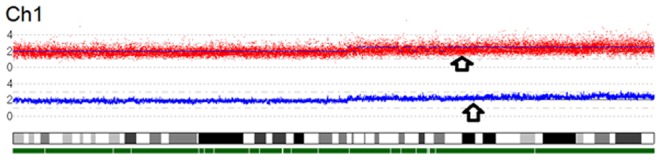
Example of CNA detected by Genome Wide 5.0 Picture generated with CNAG.The red plots (top panel) show individual SNP probe signals. In the second panel the blue line represents total gene dosage. The diploid state is indicated by 2. The chromosome 1 shows one big amplification in 1q.